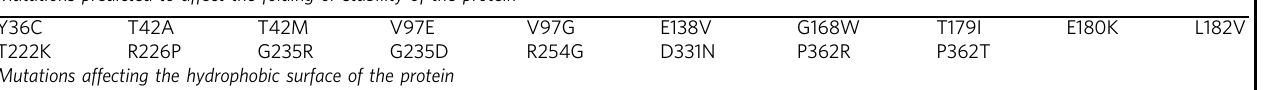
Table 2 Predicted effects of aCDase mutations found in FB and SMA-PME Mutations predicted to affect the folding or stability of the protein